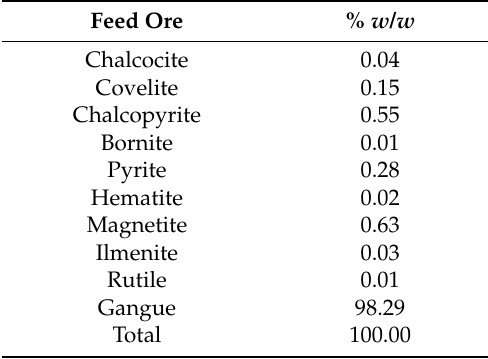
Table 2. The mineralogical composition of the feed ore determined by optical